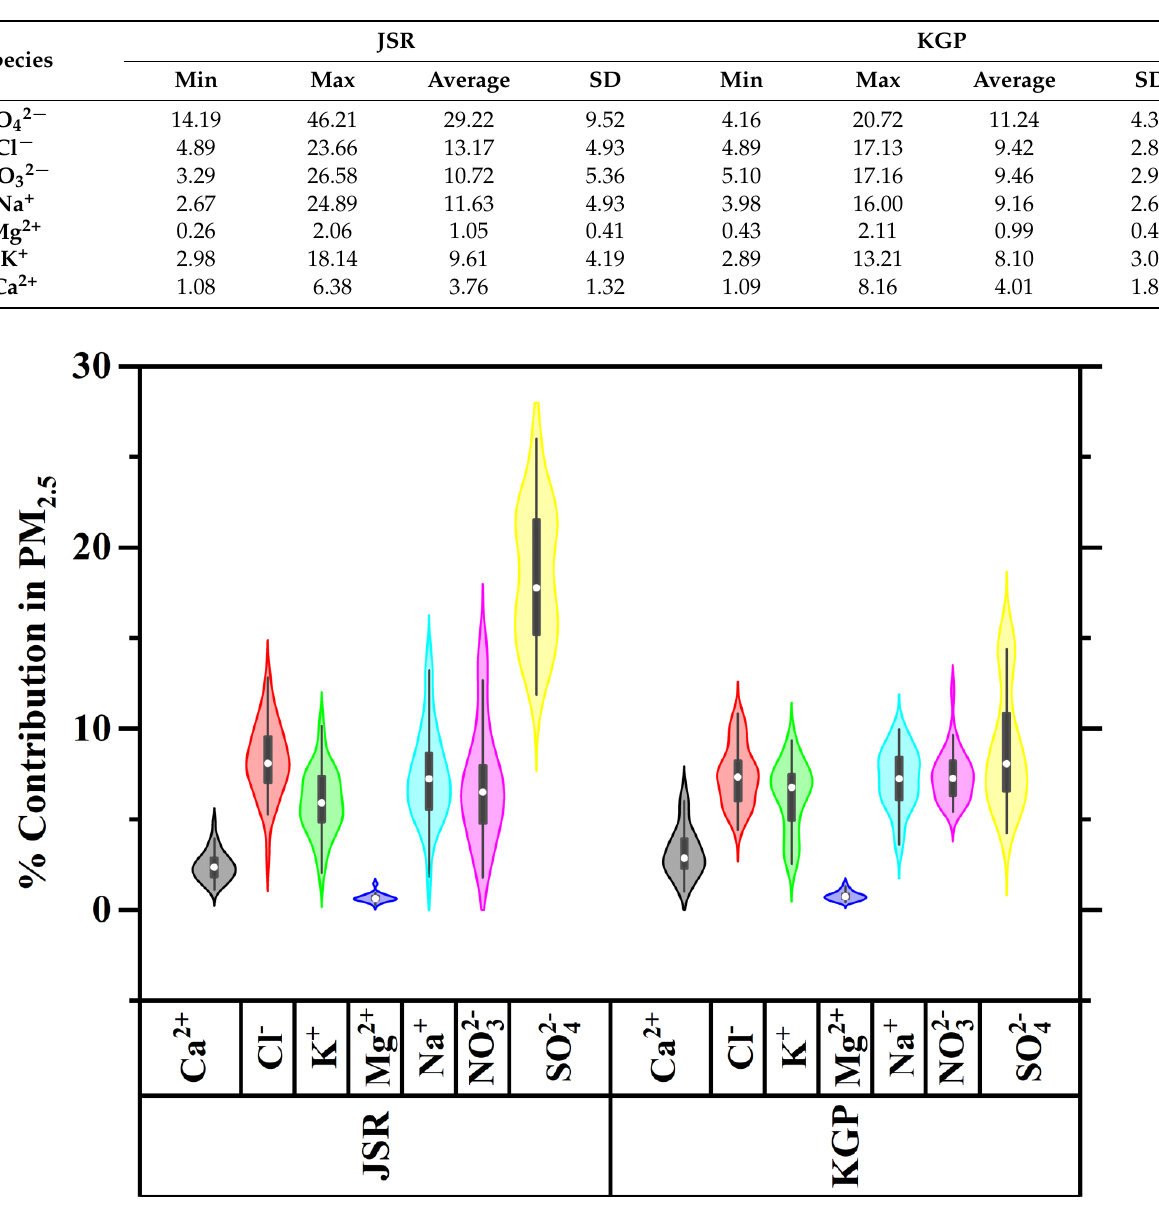
Table 3. Statistical analysis of major ionic species concentration ( µ g/m 3 ) in PM 2.5 .